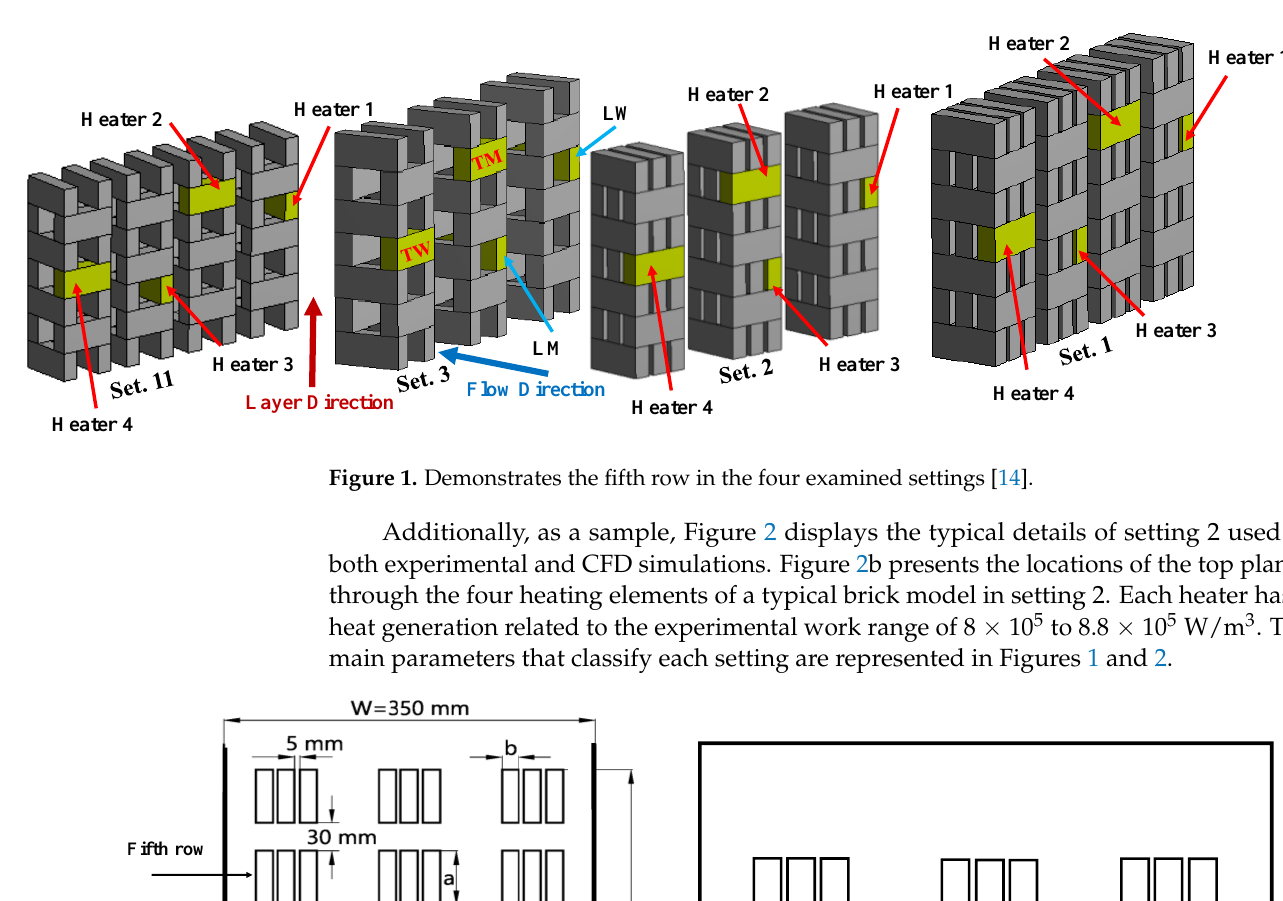
Figure 1. Demonstrates the fifth row in the four examined settings [14]. Table 1. Features of the current settings [14].